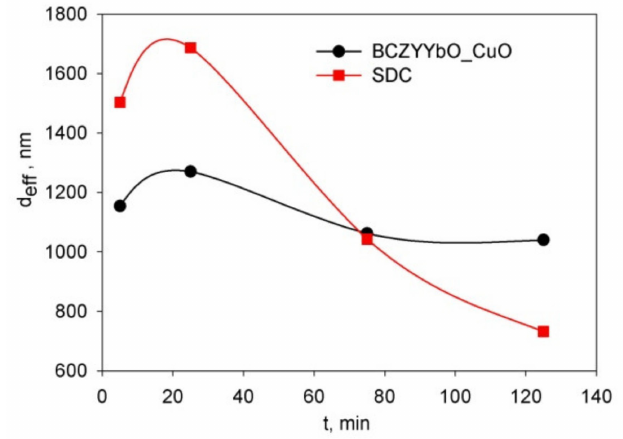
Figure 3. Schemes follow the same formatting. Dependence of the effective hydrodynamic diameter of aggregates, d eff , in the suspensions of the BCZYYbO-CuO and SDC powders on the time of the ultrasonic treatment carried out under continuous cooling.